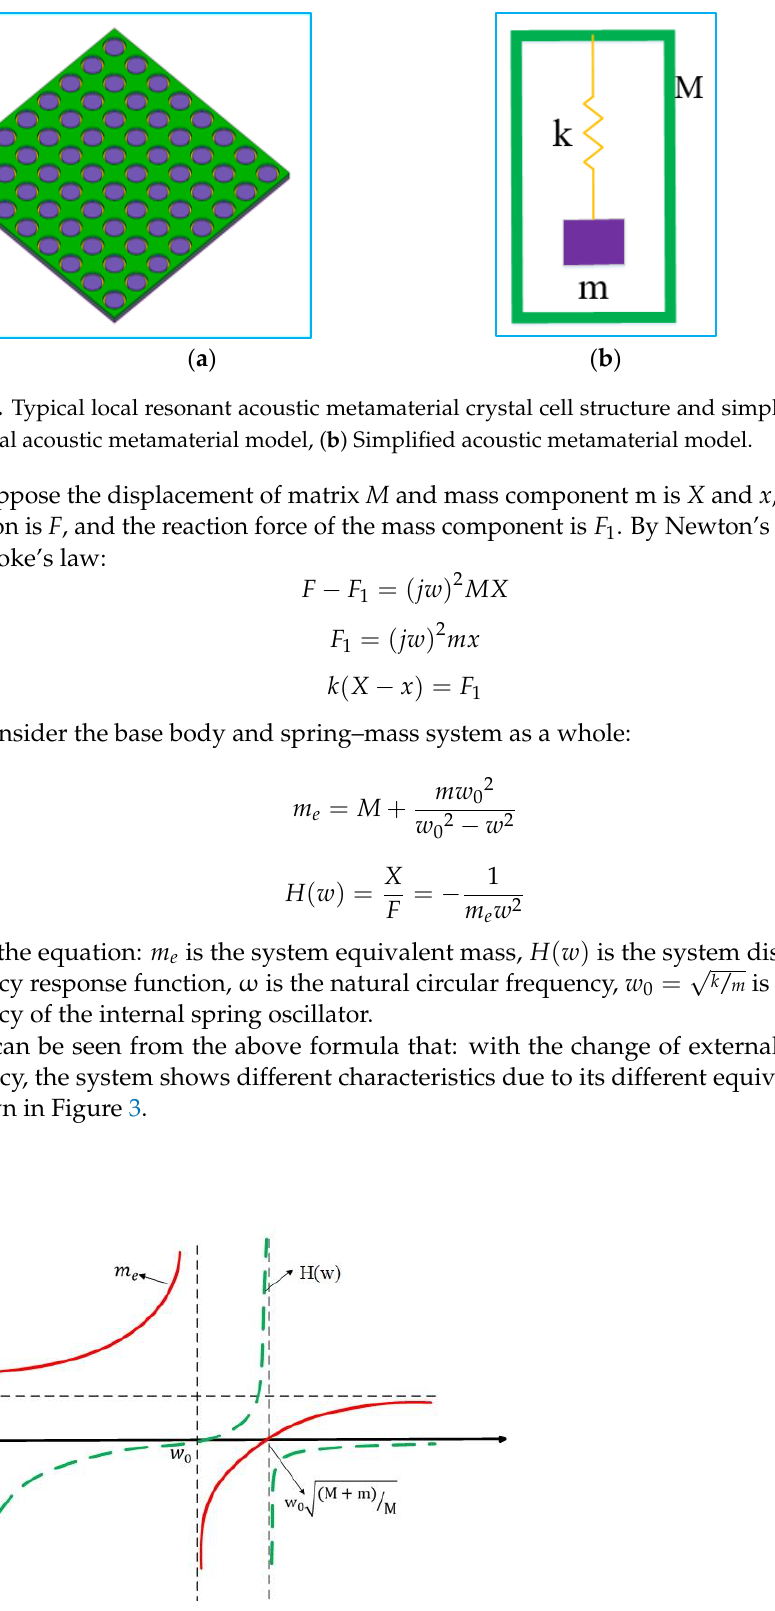
Figure 3. Relationship between external excitation frequency and displacement frequency response Relationship between external excitation frequency and displacement function.